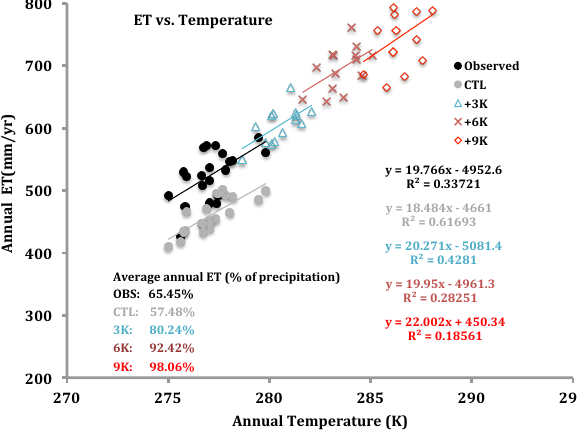
Figure 8. Annual total ET vs. annual mean air temperature. Ob- served values from the period 1979–1999 at the S2-Bog. Model val- ues for pre-treatment control simulation using weather data for the period 1979–1999, and for three levels of imposed warming ( + 3, + 6 and + 9K) based on weather data for the period 2000–2013. Re- gression lines are shown for interannual variation within each of these five